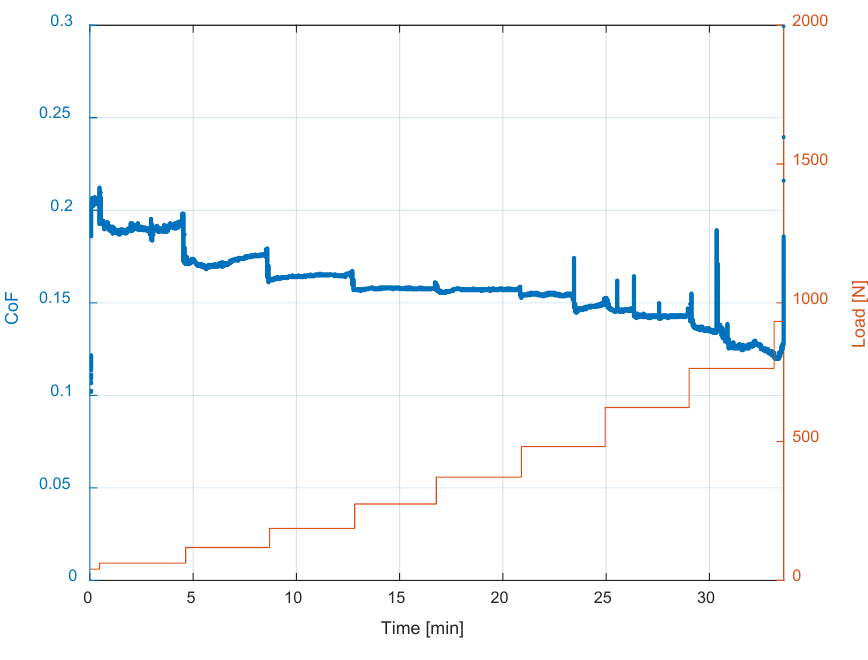
Figure 7. Case 3: example.